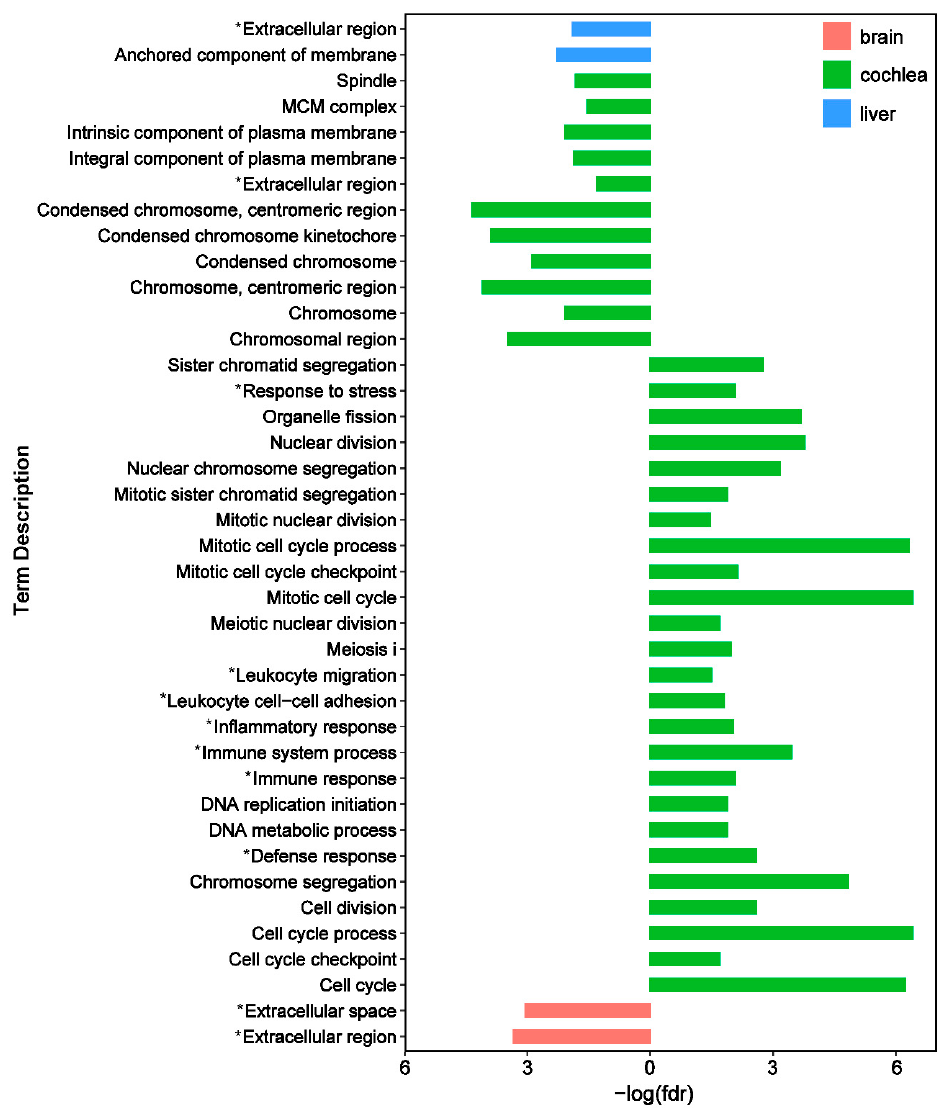
Figure 3. Significantly enriched gene ontology (GO) terms obtained using differentially expressed genes (DEGs) whose expression likely evolved under natural selection in the inter-specific comparison for three organs. Left and right indicate terms related to cellular components and biological processes, respectively. The bar colors represent different organs. ‘*’ indicates the terms also enriched in the inter-subspecific comparison.